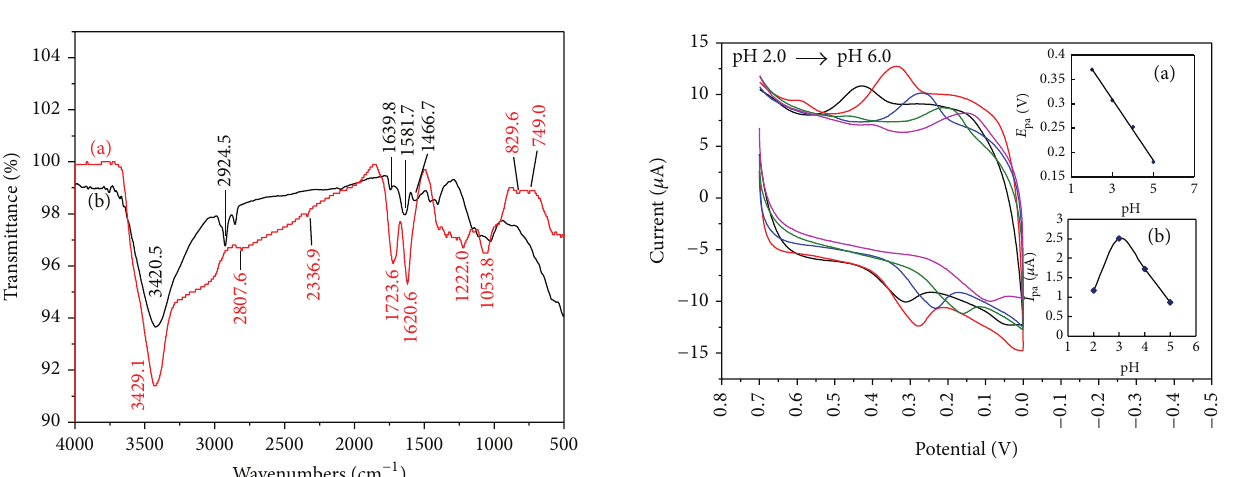
Figure 4: CVs of PDDA-G/GCE in the presence of FA (5.86 × 10 −6 M) at different pH (2.0, 3.0, 4.0, 5.0, and 6.0); inset: (a) the relationship between the anodic peak potentials and the pH; (b) the relationship between the anodic peak currents and the pH.